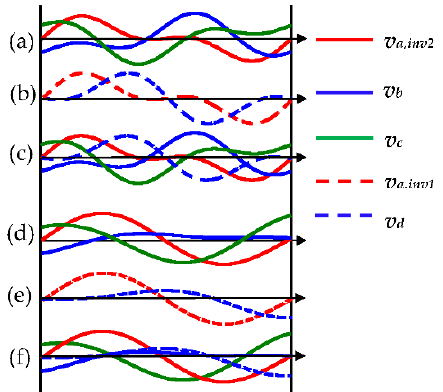
Figure 4. Typical reference phase voltage waveforms for inverters 1 and 2 for different frequency and modulation index operations. modulation index